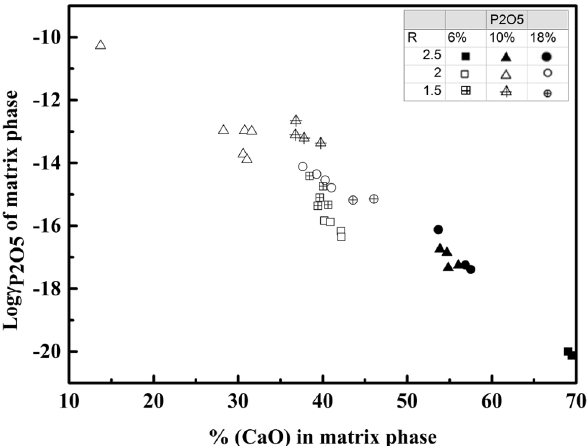
Fig. 11: The effect that mass fraction of CaO on the activity coefficient